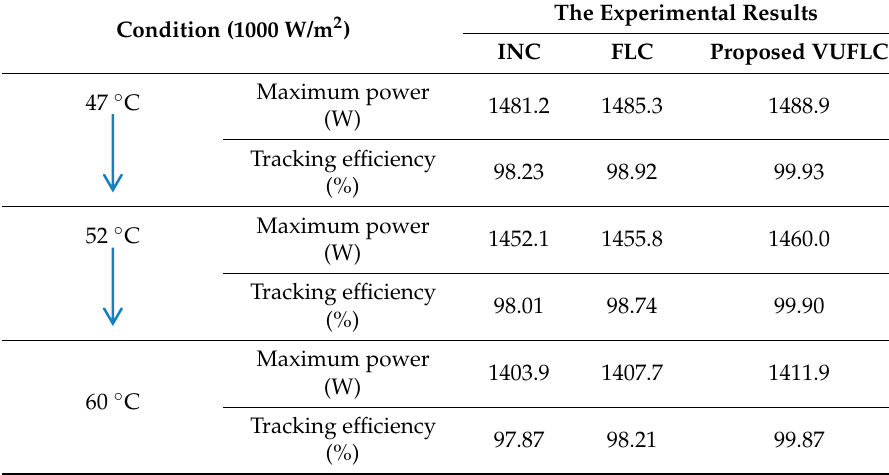
Table 5. Experimental comparison of MPPT methods.